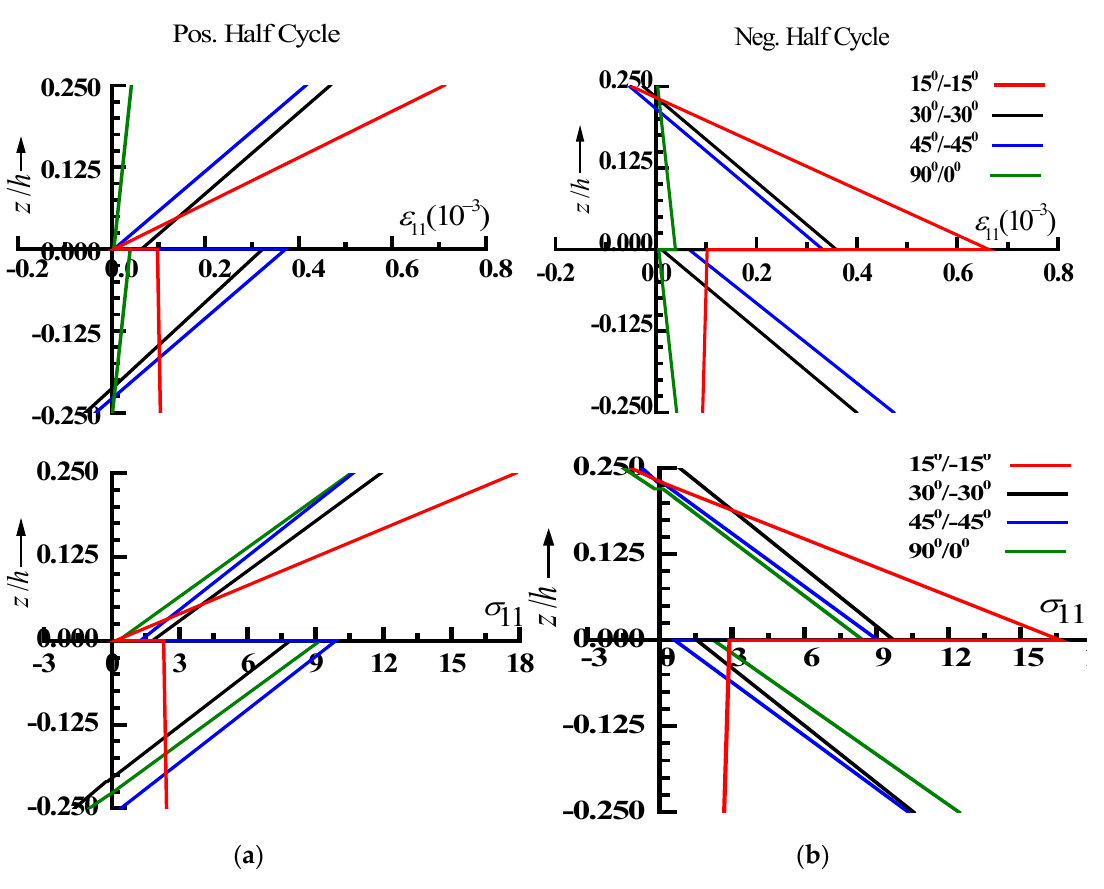
Figure 4. Nonlinear fiber direction normal strain and stress (ε 11 & σ 11 ) distribution for positive half-cycle ( a ) and negative half-cycle ( b ).